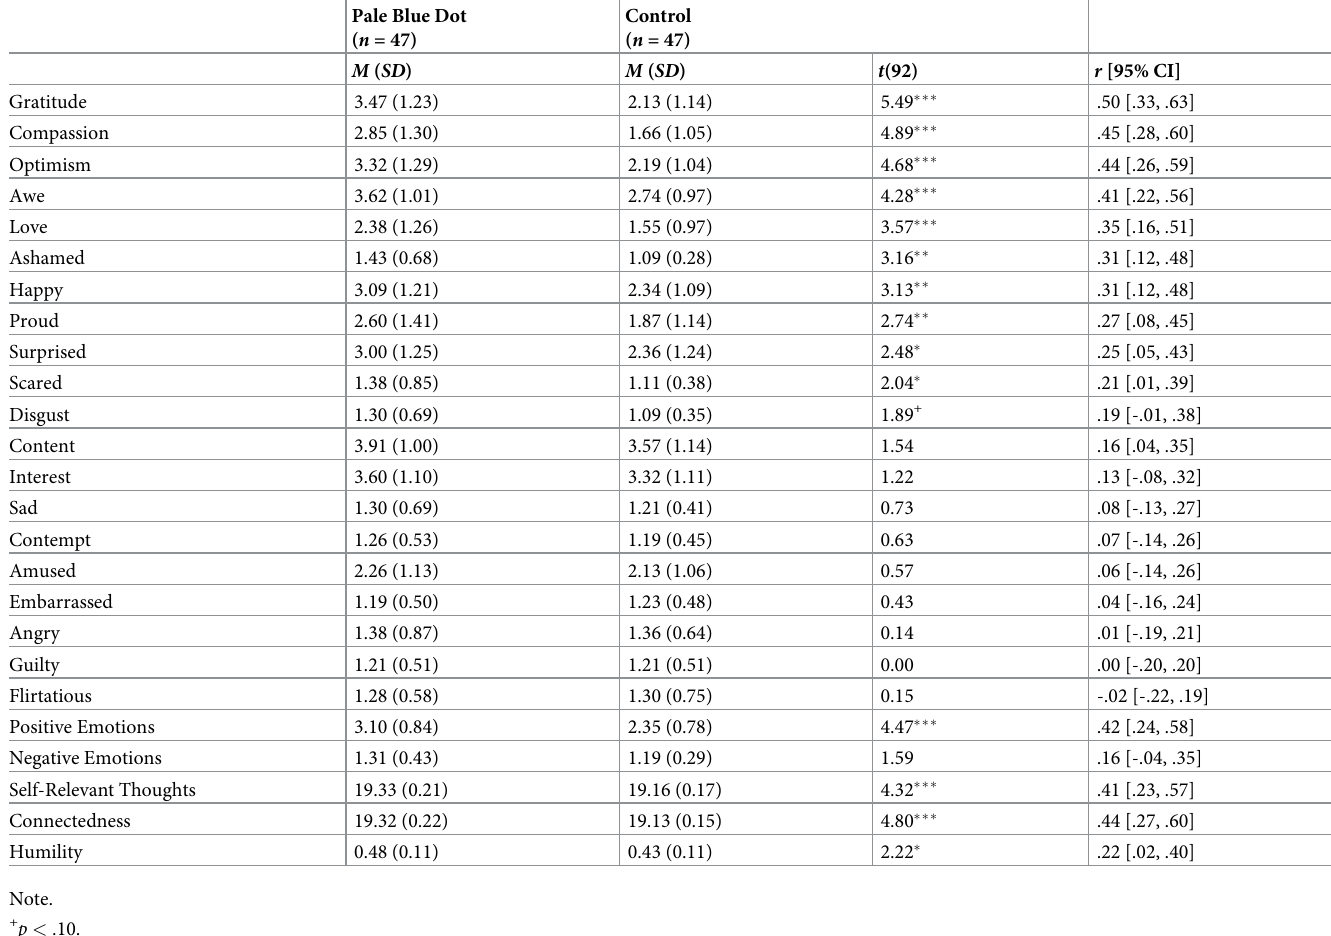
Table 1. Main effects of pale blue dot (via VR) on emotions, self-relevant thoughts, connectedness, and humility (Study 1).